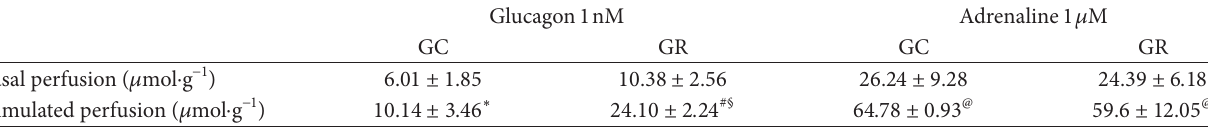
Table 1: AUCs for the liver release of glucose in the fed state.